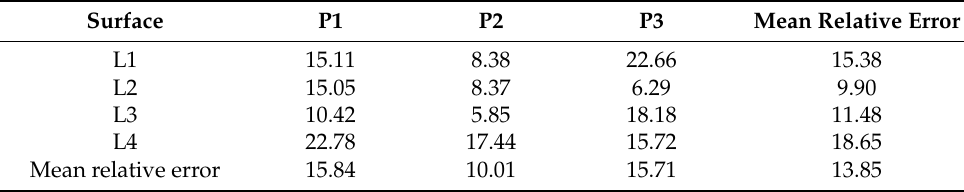
Table 2. Relative error statistics of airflow velocity simulated in the